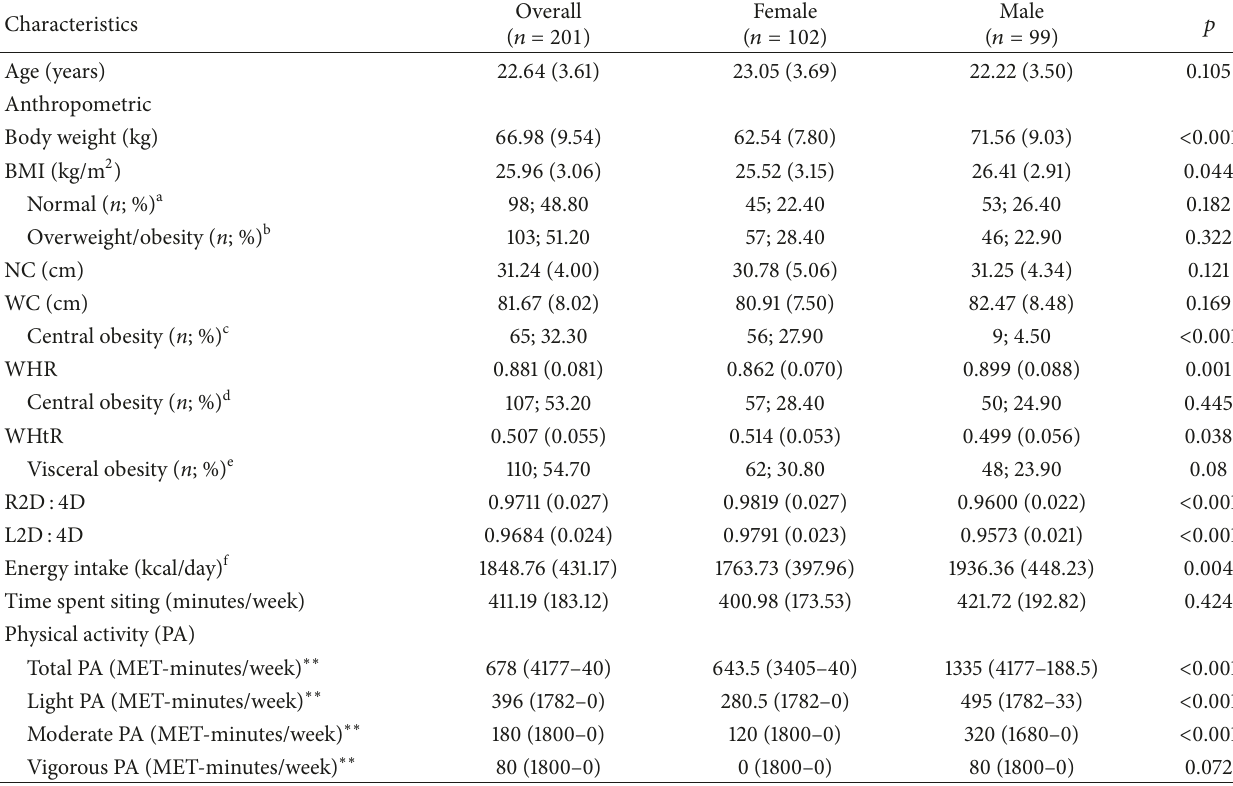
Table 1: Characteristics of the study